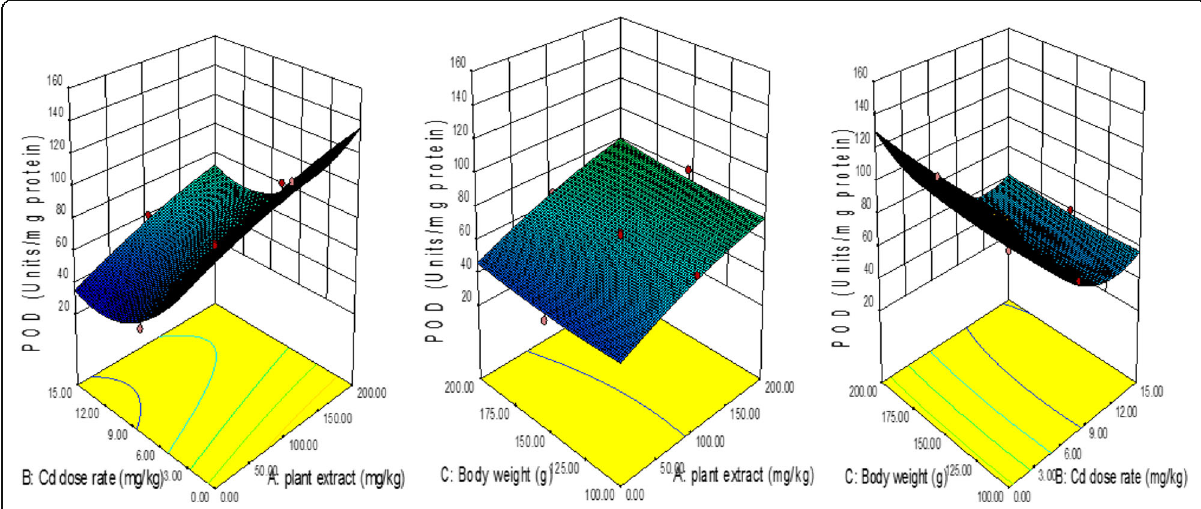
Fig. 7 3-D surface plots for serum POD activity under the influence of process variables